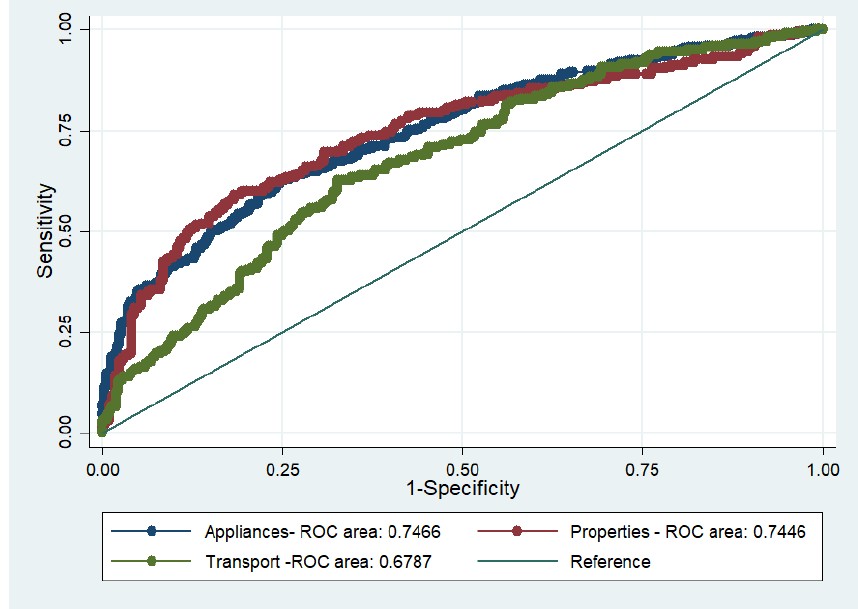
Figure 3. ROC curves and C-statistic estimates for the technological models (households).